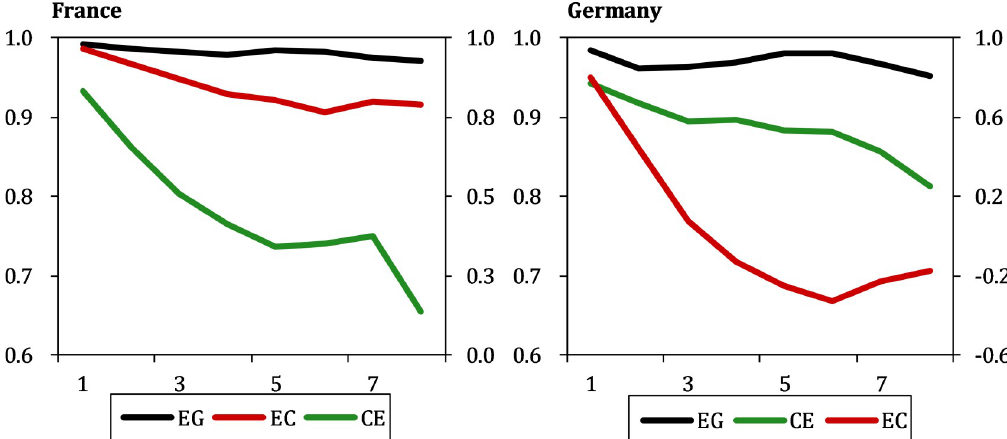
Fig 4. The nonlinearity of EC, CE, EG for France and